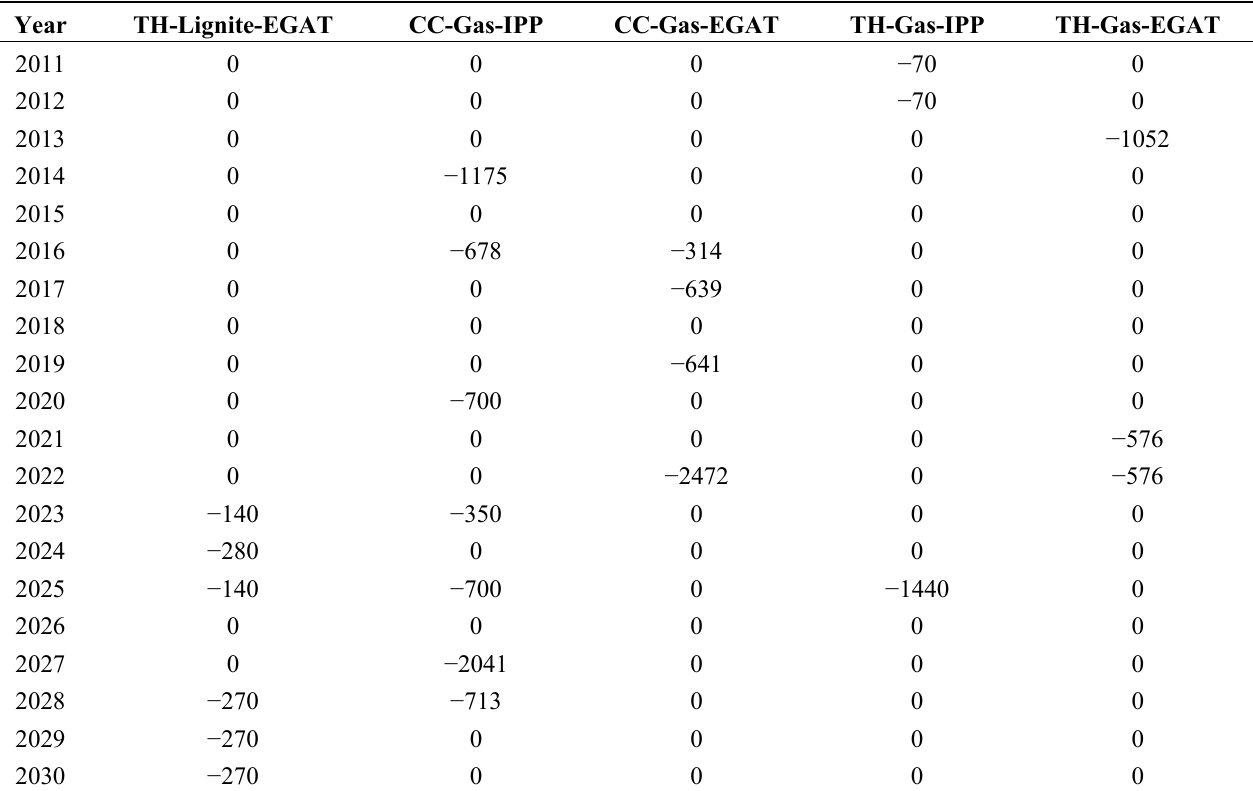
Table 2. The retirement schedule of existing plants (in MW).